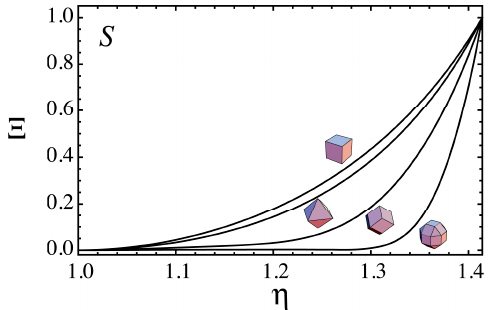
Figure 6. The relationship between Ξ and η for the hexahedral, octahedral and dodecahedral and RCO superspheres, where Ξ is a function of the Steinitz number S . It is interesting to note that this Ξ − η relation is very similar to the Π − η relation (Figure 4).